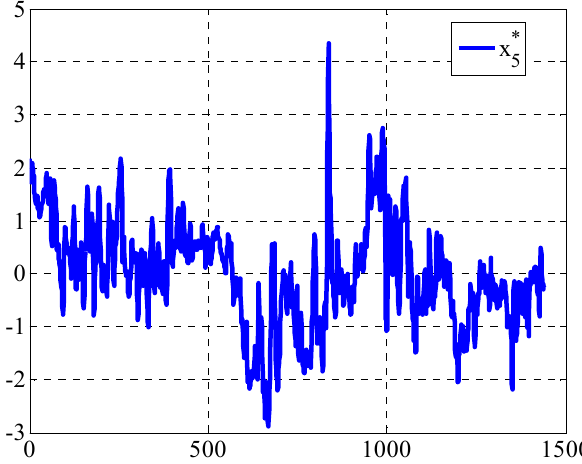
Figure 12. The standardized variable x ∗